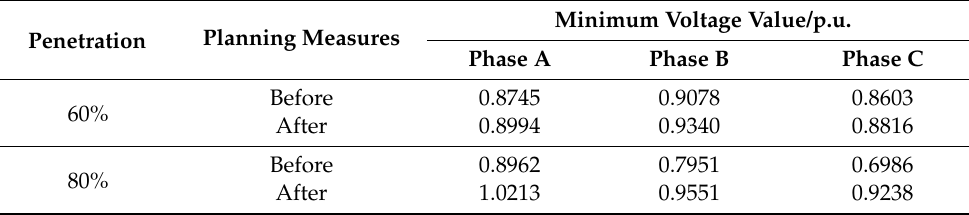
Figure 9. Comparison of three-phase voltage magnitude after optimization. ( a ) Comparison of three- phase voltage magnitude after no-excitation voltage regulation with penetration rate of 60%. ( b ) Com- parison of three-phase voltage magnitude after the penetration rate is 80% capacity-enhancing platform. Table 1. Statistical table of minimum three-phase voltage after optimization of grid structure.